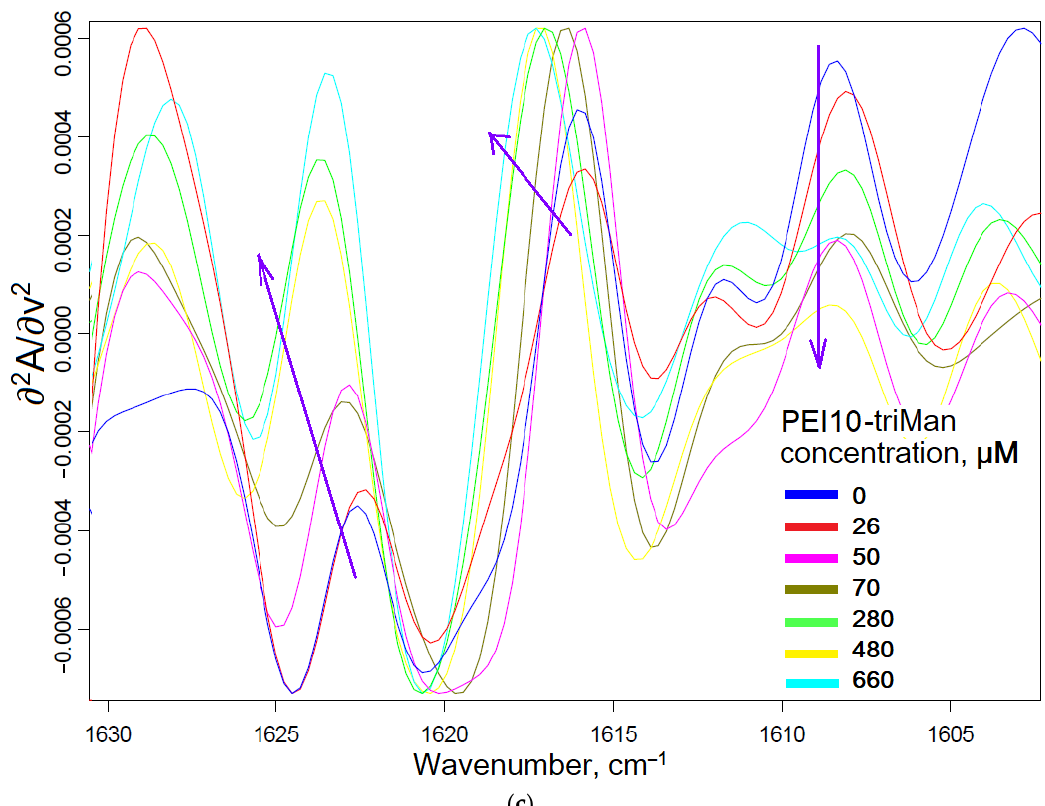
Figure 4. ( a ) Fourier transform infrared spectra of ConA and ConA complexes with PEI1.8-triMan. ( b ) Dependences of the intensity of amide I and amide II peaks in the FTIR spectra from Figure 4a. On the insert, the Hill linearization plot of the presented curves is given. ( c ) Second derivative (d 2 A/d ν 2 ) of FTIR spectra of ConA and ConA complexes with PEI10-triMan. The arrows show the shifts during the complexation of the protein with the increasing concentration of ligand. [L], the equilibrium concentration of the ligand; θ , proportion of bound receptor. C 0 (ConA subunit) = 0.1 mM. Natrium-phosphate buffer solution (0.02 M, pH 6.4). C(Ca 2+ ) = C(Mn 2+ ) = 1 mM. T = 25 °C.